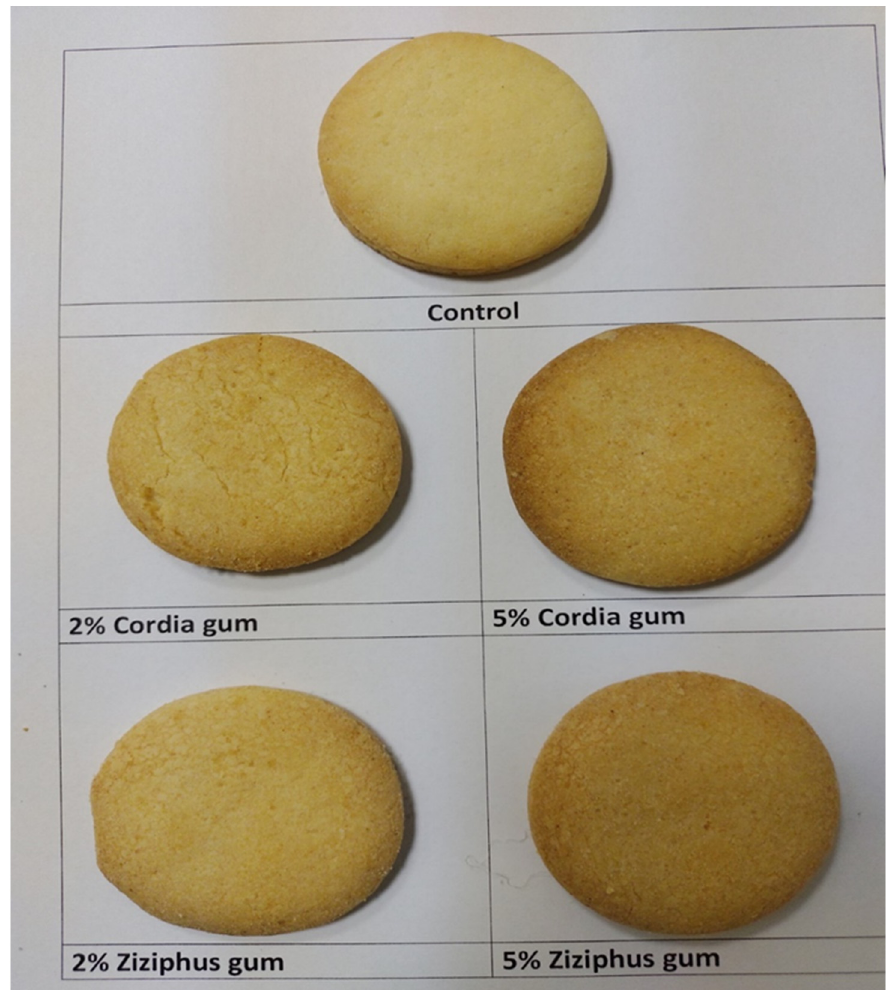
Figure 4. Pictures of cookies prepared from the control (wheat flour) and different blends.